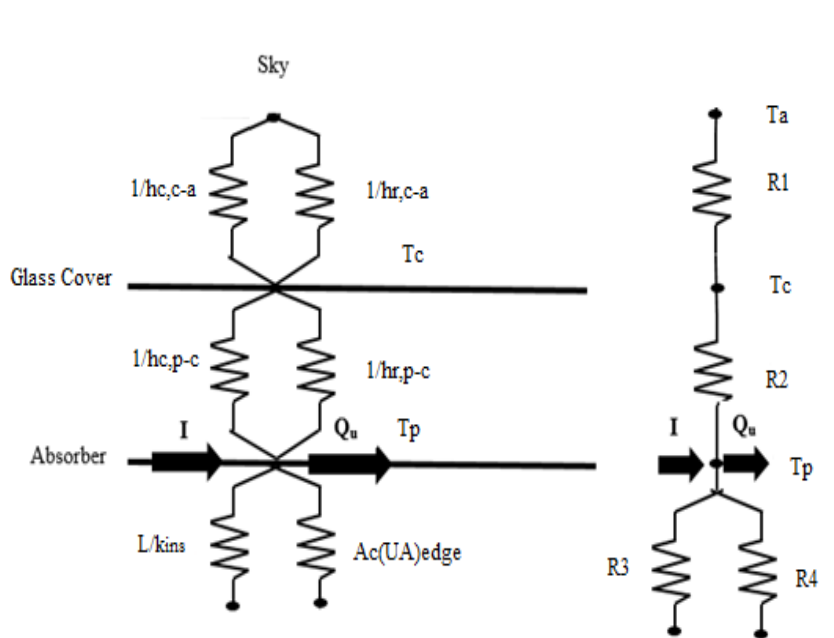
Figure 2. Conical protrusion rib roughness [28].